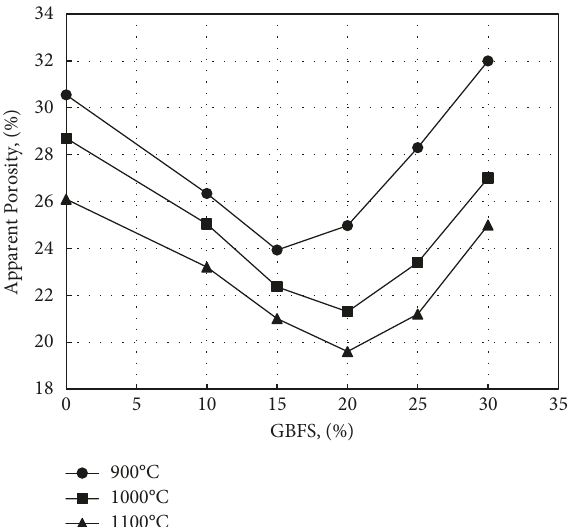
Figure 14: Effect of GBFS addition on total and closed